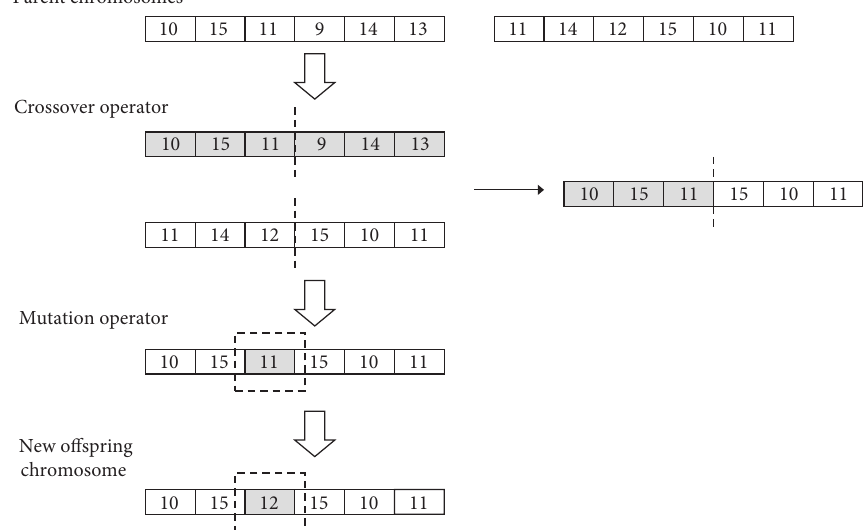
Figure 8: The crossover and mutation process of method G ( S ).